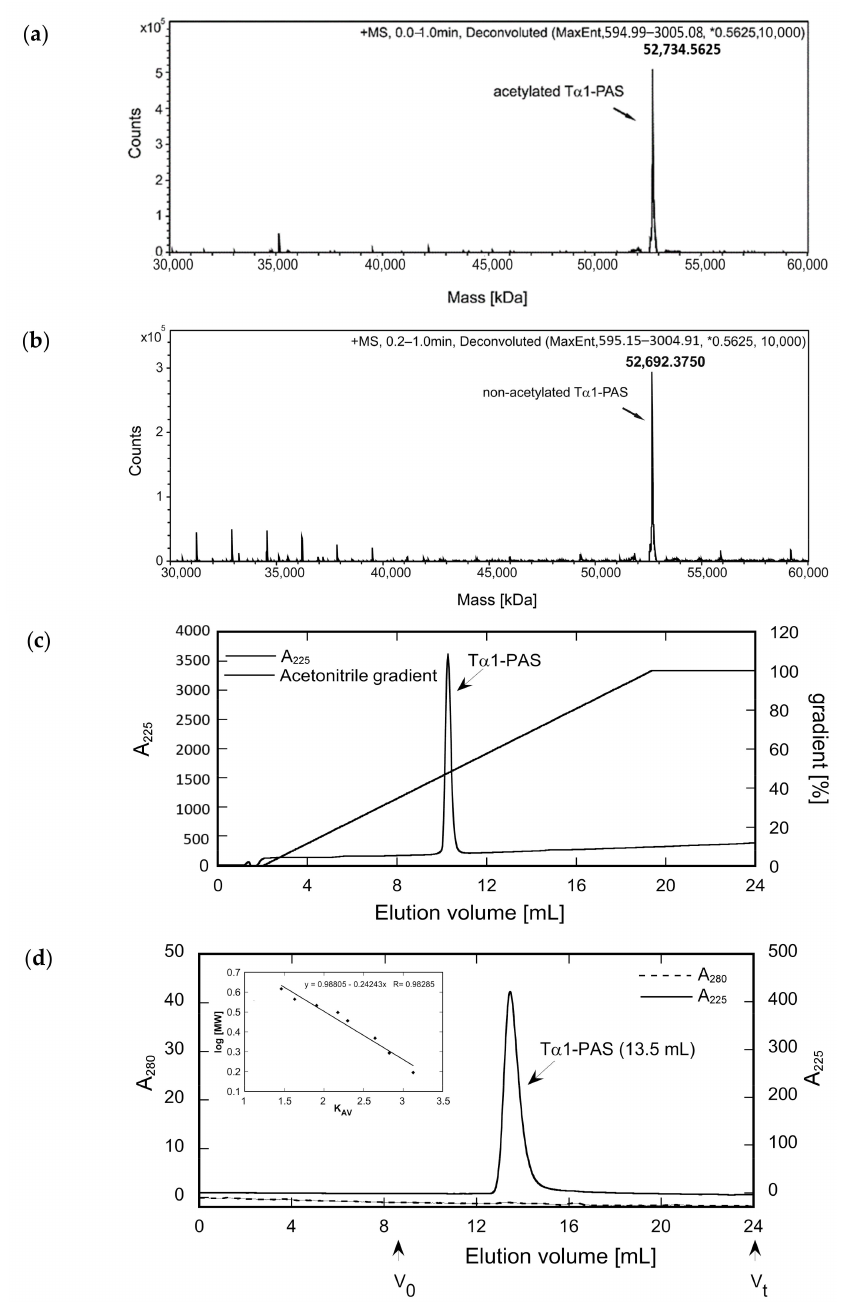
Figure 2. Analysis of T α 1-PAS N-acetylation, peptide purity, and hydrodynamic volume. ( a ) The deconvoluted ESI-MS spectrum of the T α 1-PAS flow-through fraction after the subtractive AEX step (see text) shows a molecular mass of 52,734.56 Da, corresponding to N-acetylated T α 1-PAS (calc. mass: 52,734.56 Da). ( b ) ESI-MS analysis of the bound and eluted peptide fraction from the same chromatography reveals a molecular mass of 52,692.37 Da, which matches the calculated mass of non-acetylated T α 1-PAS (52,692.54 Da). ( c ) Reverse-phase chromatography of the flow-through fraction indicates a purity > 96% for N-acetylated T α 1-PAS. ( d ) Analytical SEC of the finally purified T α 1-PAS in the presence of phosphate-buffered saline (PBS) results in a single peak with an elution volume of 13.5 mL. Comparison with a half-logarithmic calibration curve (inset) indicates an expanded hydrodynamic volume with an apparent molecular size of 557